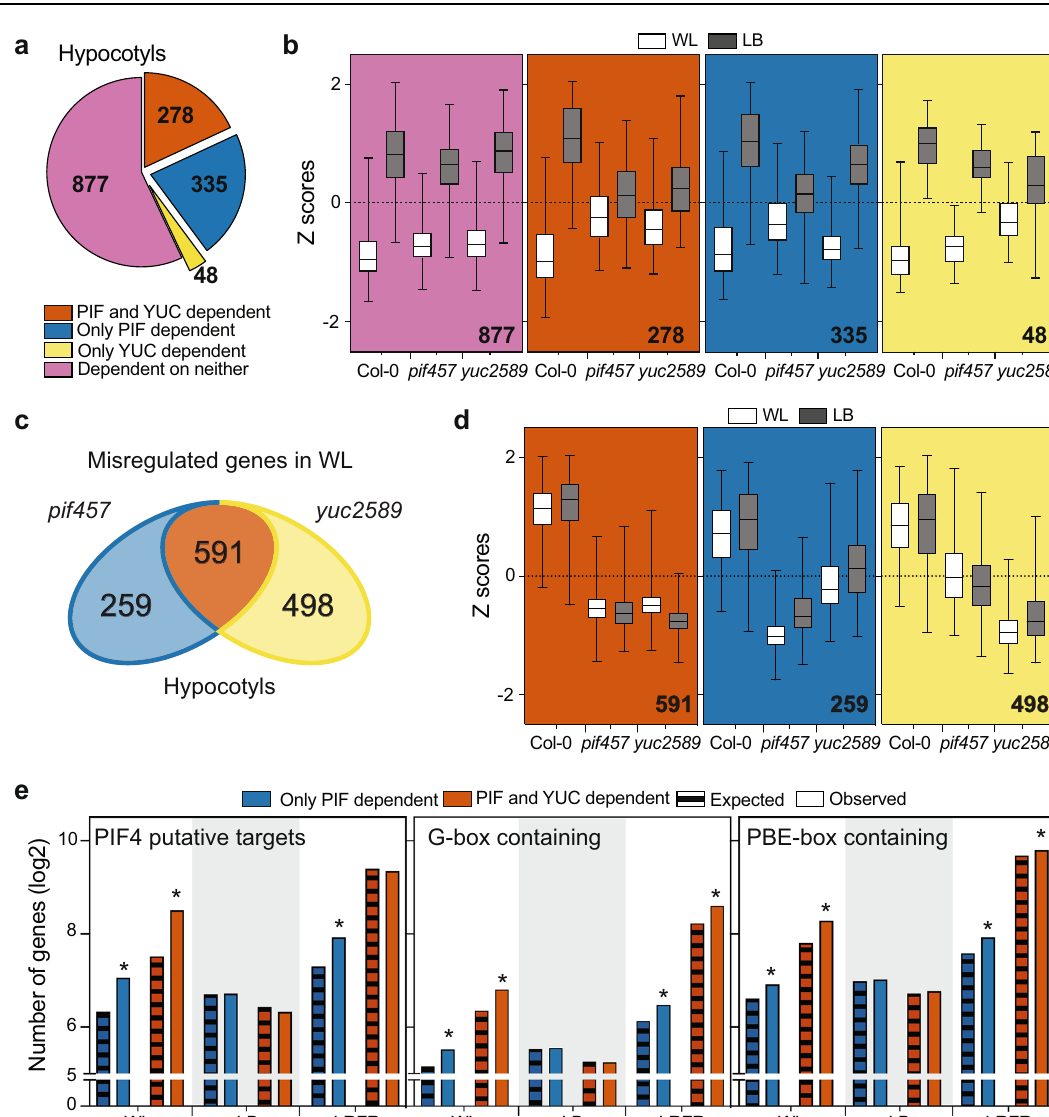
hypocotyls with putative PIF4 targets (as listed in ref. 26), promoters (1kb upstream)containingG-box(CACGTG)orPBE-box(CATGTG).Asterisks(*)indicate the statistically signi fi cant overrepresentation compared to expected ( P <0.05, Binomial distribution, one-tailed; the exact P values are available in the Source Data). b , d Thehorizontalbarrepresentsthemedian;boxesextendfromthe25thto the 75th percentile, whiskers extend to show the data range. Numbers indicate signi fi cantlyregulatedgenesinthegivencategoriesand/orGOterms.Thefulllistof misregulated genes, enriched GO terms, and enriched motifs are given in Supple- mentary Data 4, 5, and 6. See also Supplementary Fig.